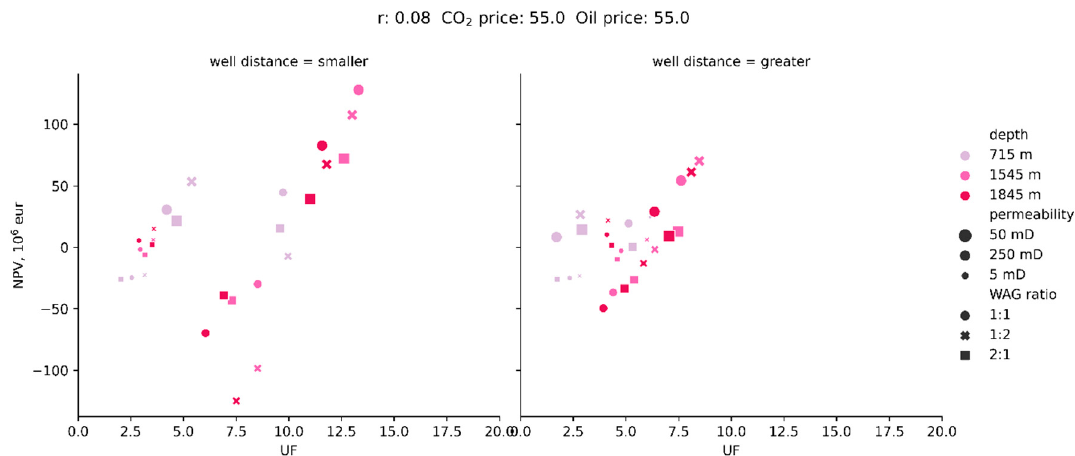
Figure 15. NPV versus UF for the optimistic scenario at the end of EOR with 20 € /MWh electricity price.